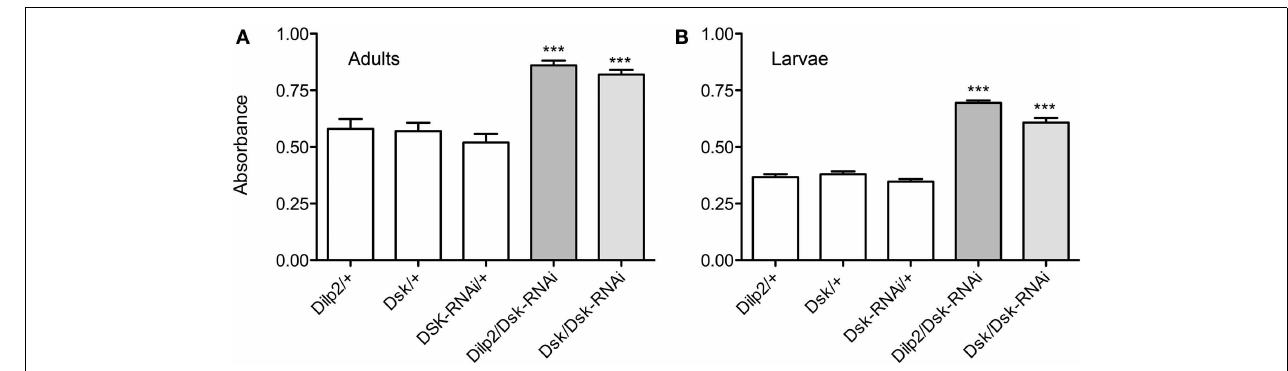
Dilp2/ + , Dsk/ + , and Dsk-RNAi/ + ( p < 0.001, One-way ANOVA), indicating a larger food intake amongst the flies with DSK-knockdown both in all DPCs and only in IPCs. (B) DSK regulates food intake also in larvae. After 15min of feeding, a mean absorbance of 0.60 in Dsk-Gal4/Dsk-RNAi and 0.695 in Dilp2/Dsk-RNAi larvae was measured compared with 0.35, 0.37, and 0.38 in controls ( p < 0.001, One-way ANOVA).The Dsk/Dsk-RNAi and Dilp2/Dsk-RNAi larvae displayed an almost 50% higher absorbance than controls. For all experiments manipulations the IPCs alone were sufficient to induce a feeding